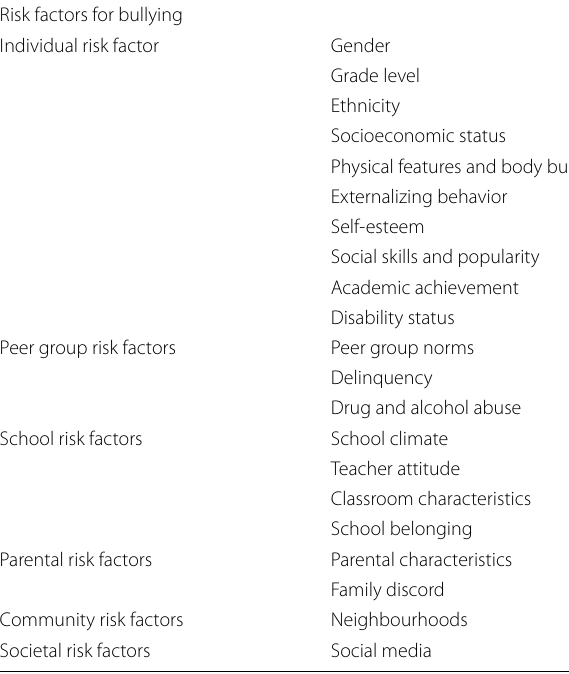
Table 1 Summary of risk factors for bullying Risk factors for bullying Individual risk